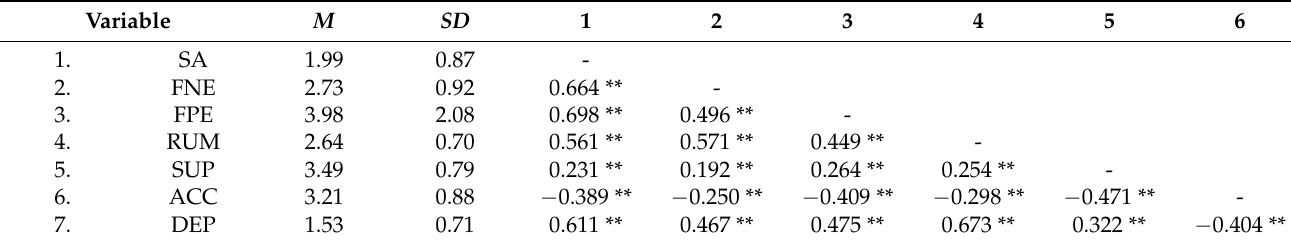
Table 2. Means, standard deviations, and correlations.